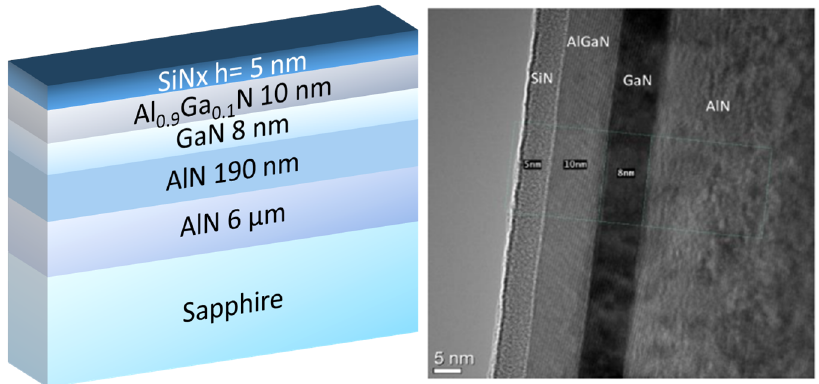
Figure 1. Schematic cross section of the thin channel structure (left) and high resolution Transmission Electron Microscopy picture of the active layers grown by molecular beam epitaxy (MBE) (right).